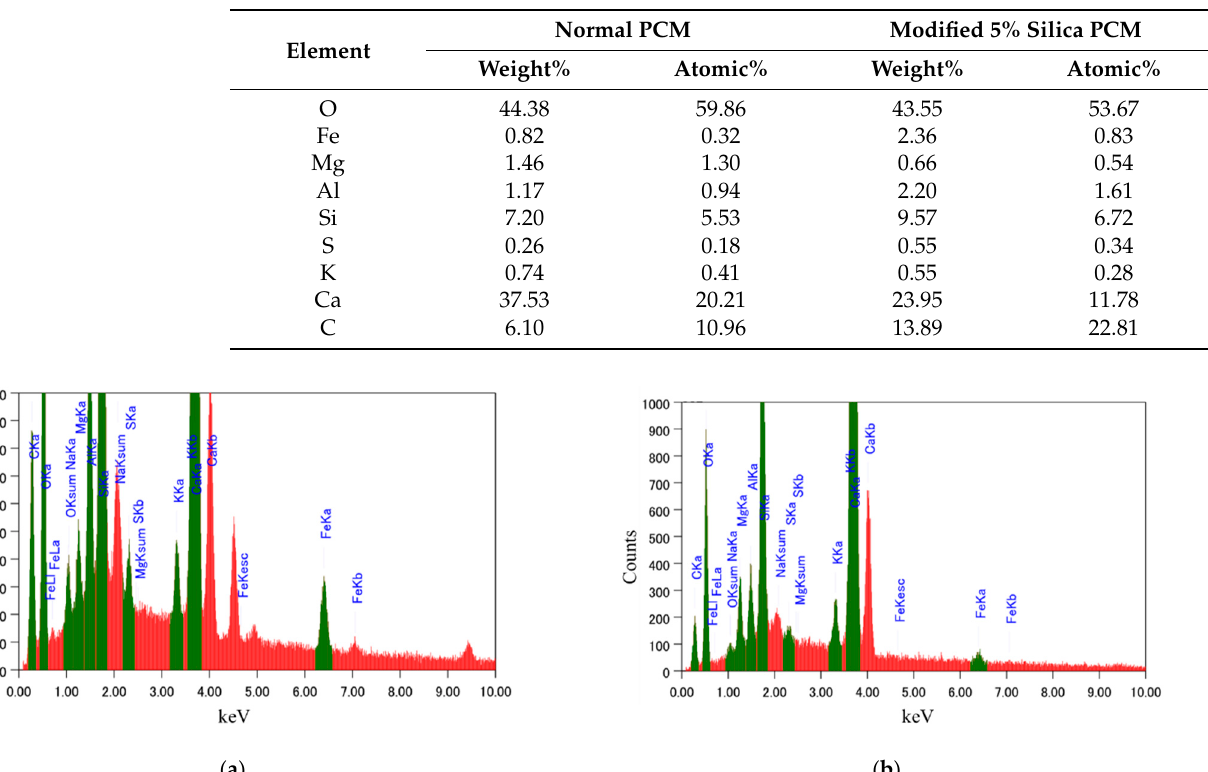
Figure 5. EDS elemental spectrum at a specific point along the interface of the composite specimen. ( a ) Normal PCM, ( b ) modified 5% silica PCM. ( a ) Normal PCM, ( b ) modified 5% silica Table 6. EDS elemental quantification results.